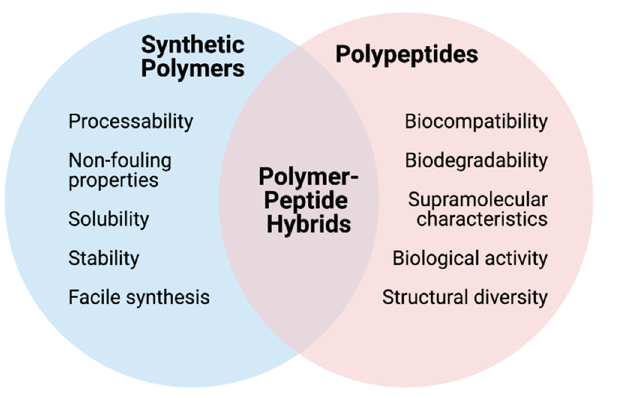
Figure 1. Respective contributions of synthetic polymers and polypeptides towards polymer-peptide hybrid materials.